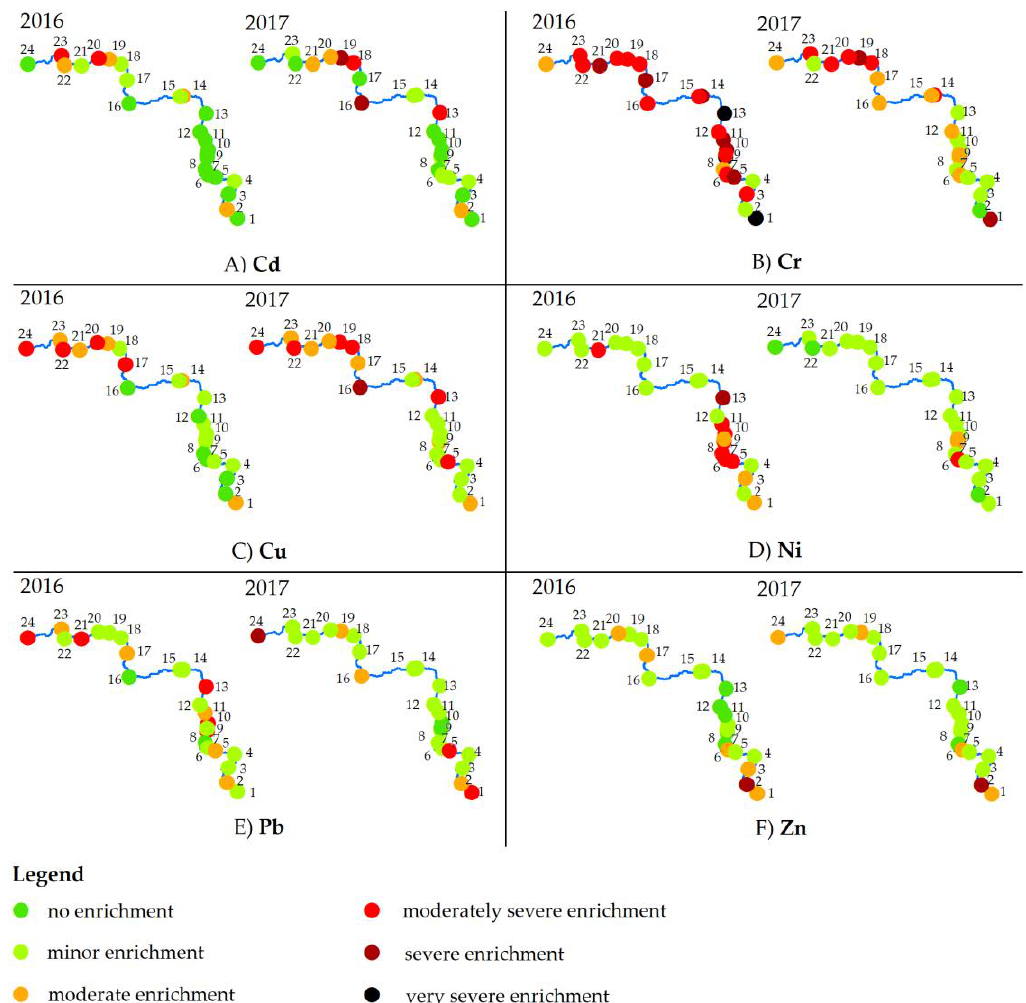
Figure 6. Enrichment Factor (EF) in bottom sediments of Warta River in 2016 and 2017. The EF values calculated for Cd and Cu signaled the heavier contamination of the bottom sediments in the lower course of the Warta River. In 2016 for Ni the highest EF were obtained for the bottom sediments from the middle course of the river, while for Pb a similar level of contamination was noted along the whole course of the river.